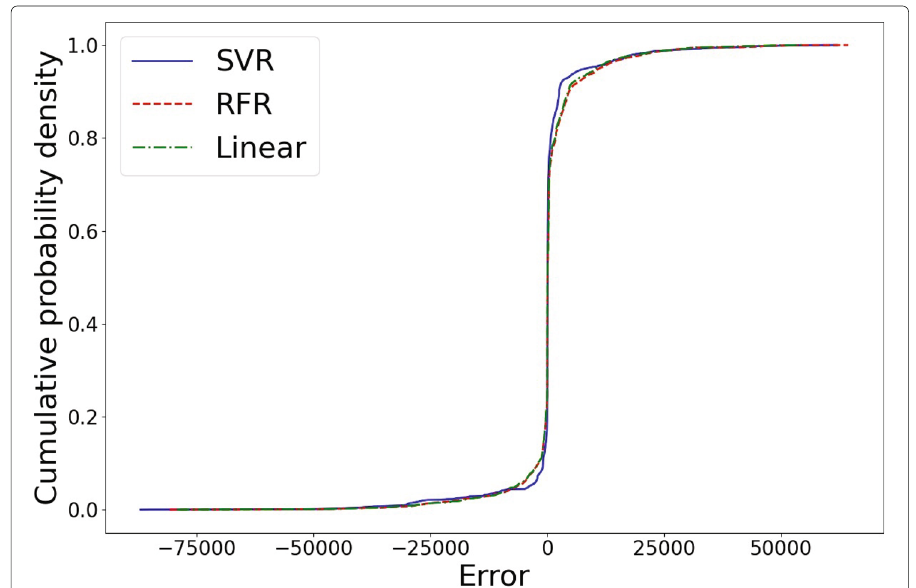
Fig. 9 Cumulative error